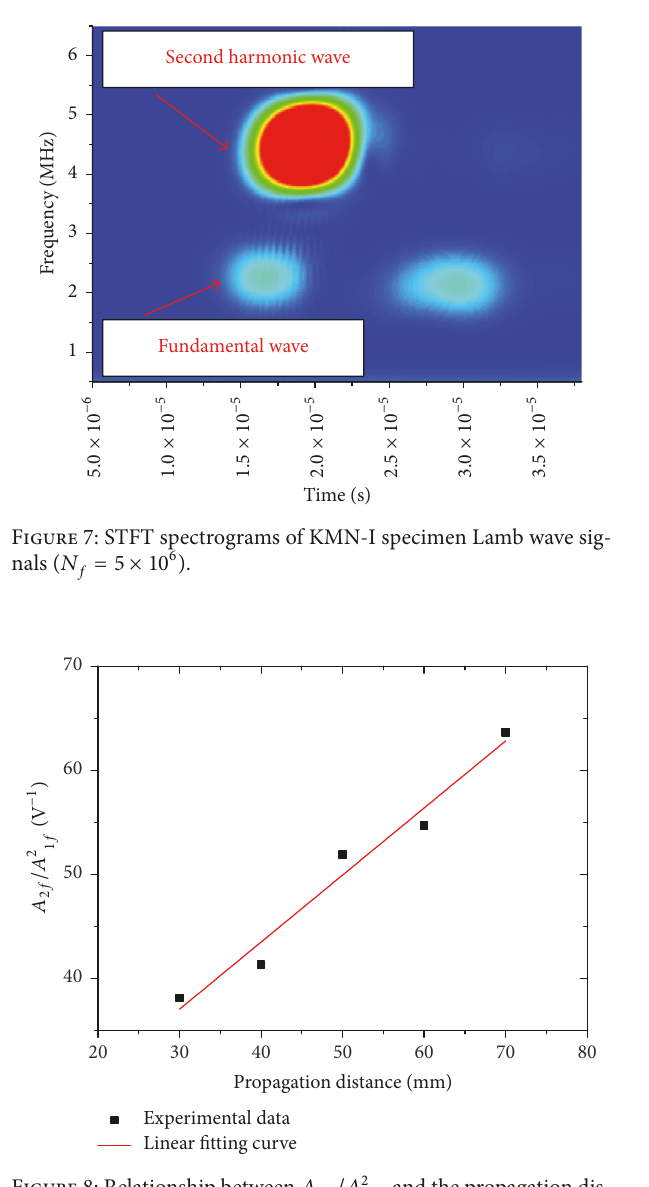
Figure 8: Relationship between 𝐴 2𝑓 /𝐴 2 1𝑓 and the propagation dis- tance.